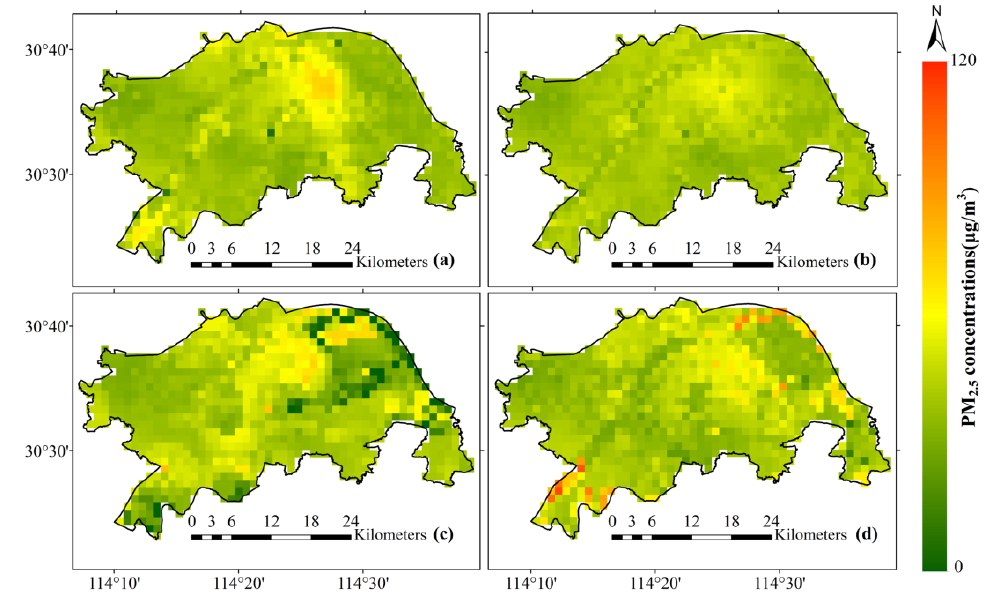
Figure 9. Mapping results of the estimated PM 2.5 concentration using different variables. The variables used in (a)–(d) correspond to those in Figure 8 respectively.